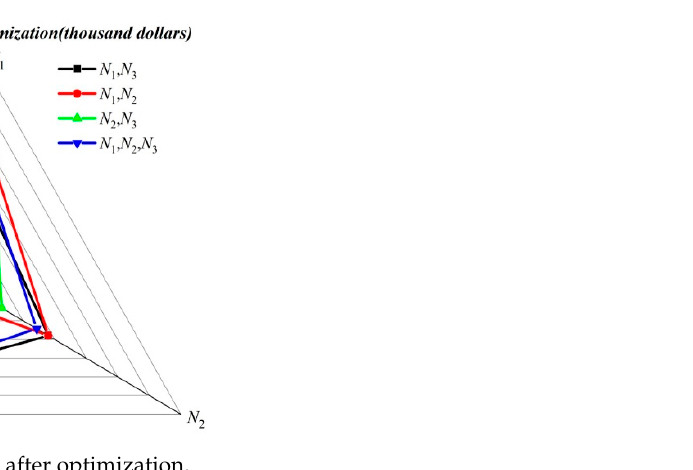
Figure 6. Crop revenue before optimization.